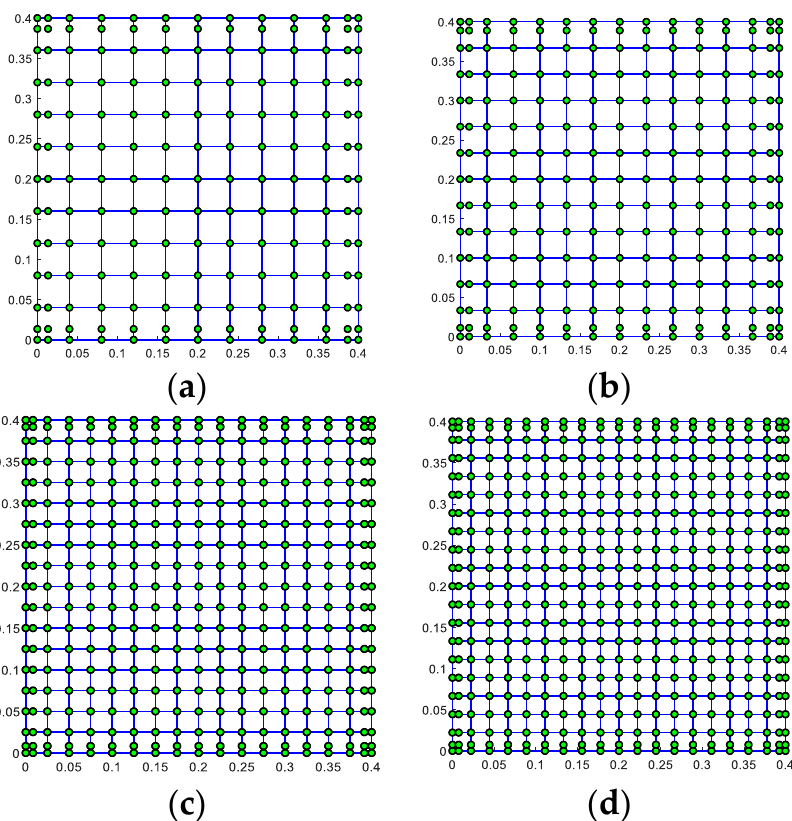
Figure 4. Four different control meshes of a square piezoelectric functionally graded plate (PFGP) with a fully simply supported boundary: ( a ) 10 × 10; ( b ) 12 × 12; ( c ) 16 × 16; ( d ) 18 × 18.